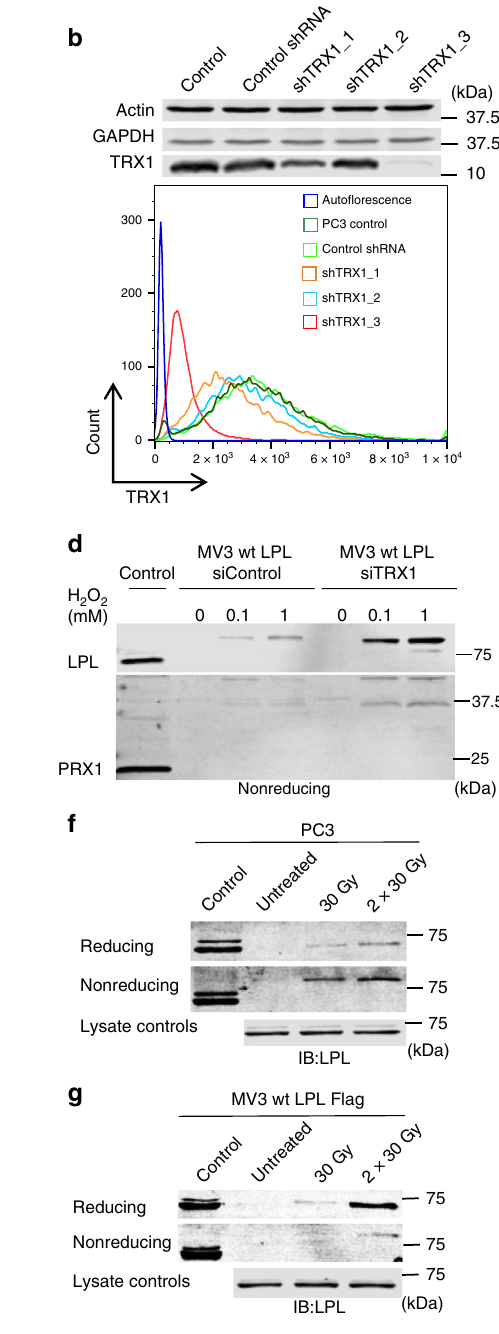
concentrations may occur through spatially con fi ned ROS pro- duction or at locations with low antioxidative protection. Given the regulatory effect of TRX1 on the oxidation state of LPL, we next determined the subcellular localization of LPL, TRX1, and F- actin in MV3 cells expressing eGFP-fused LPL in the presence or